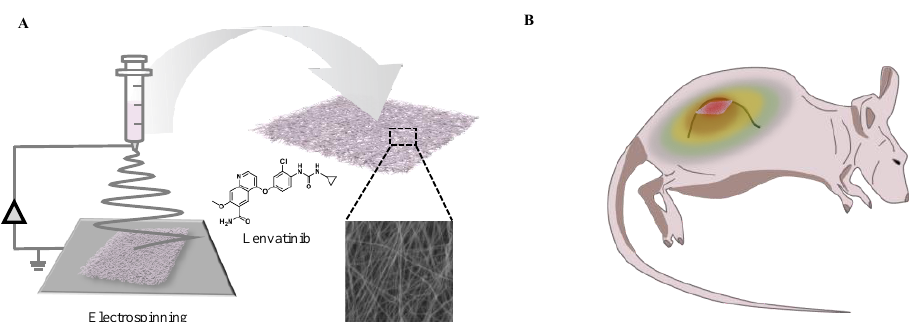
Figure 1. ( A ) Design concept for a smart nanofiber system that incorporated lenvatinib using the electrospinning method. ( B ) The nanofiber allows for the sustained release of lenvatinib at the local tumor site through diffusion. Localized administration of molecular-targeted drugs can improve the therapeutic efficiency.